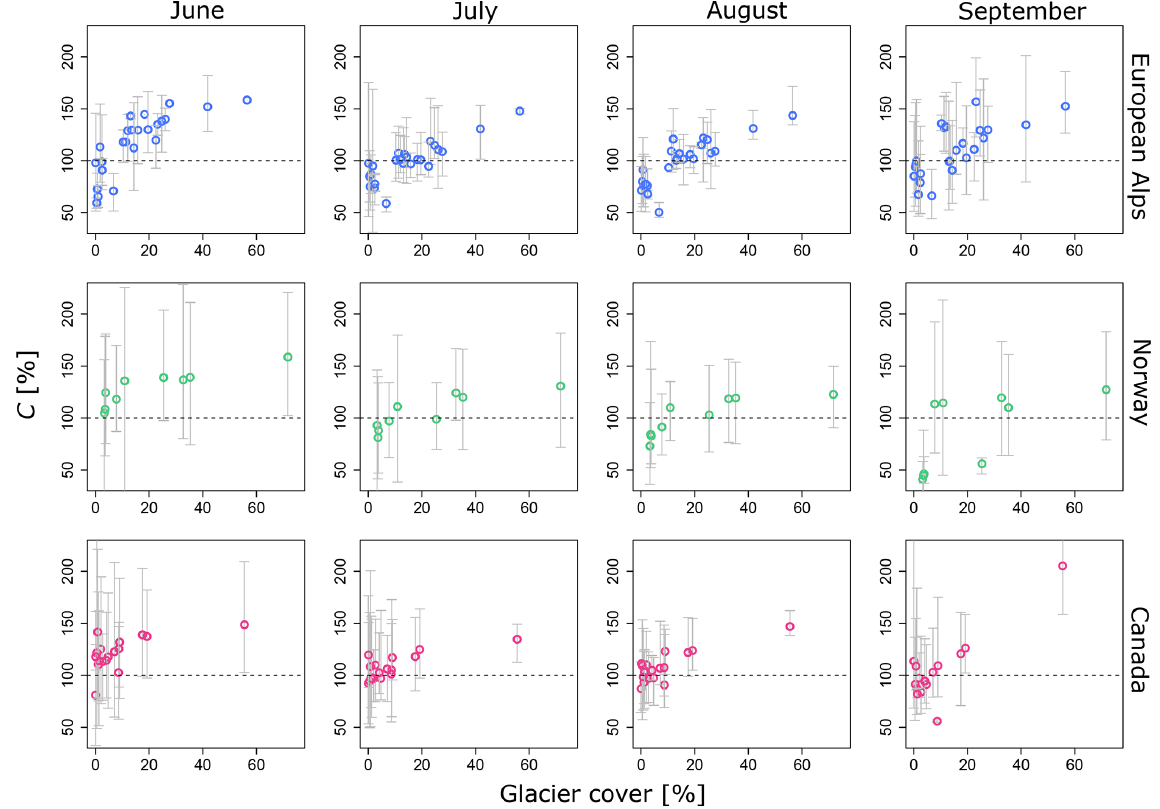
Figure 4. Level of compensation ( C ) during WD events for the different regions (rows) and the different months (columns) against gc of the different catchments. The colored circles indicate the mean streamflow response, and the gray bars show the range of C , i.e., the minimum and maximum C